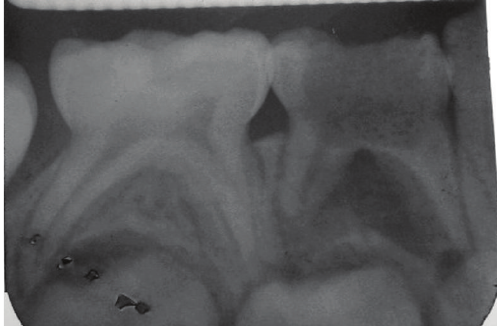
Figure 1: IOPA showing metallic screw in the pulp chamber of #84 with intact pulpal floor.